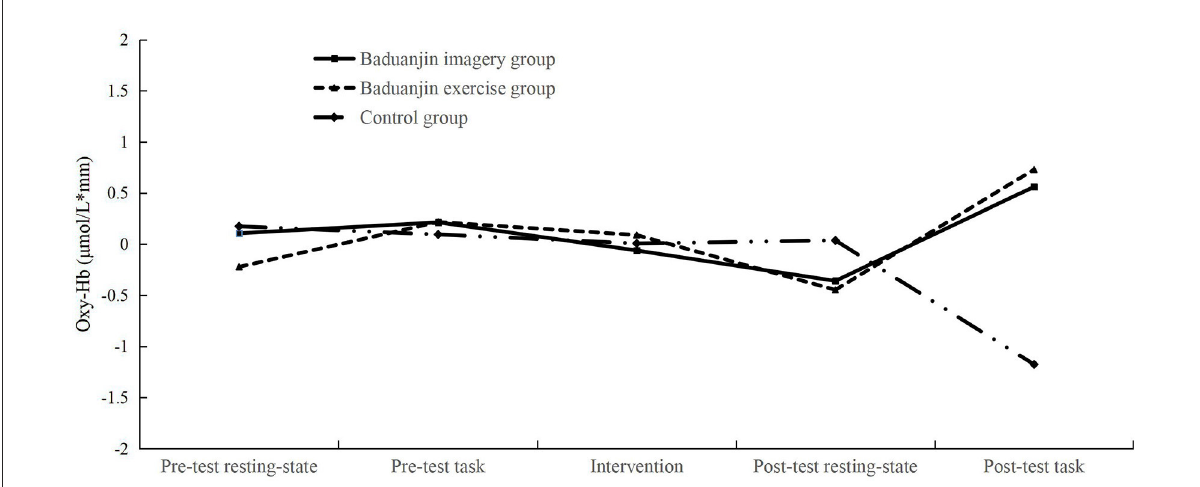
FIGURE4 In the incongruent task, the mean oxy-Hb concentration variations of the left DLPFC for the three groups of participants ( µ mol/L × mm). After the intervention, the oxy-Hb variations were significantly higher in participants of the Baduanjin imagery group and Baduanjin exercise group than in the Control group.